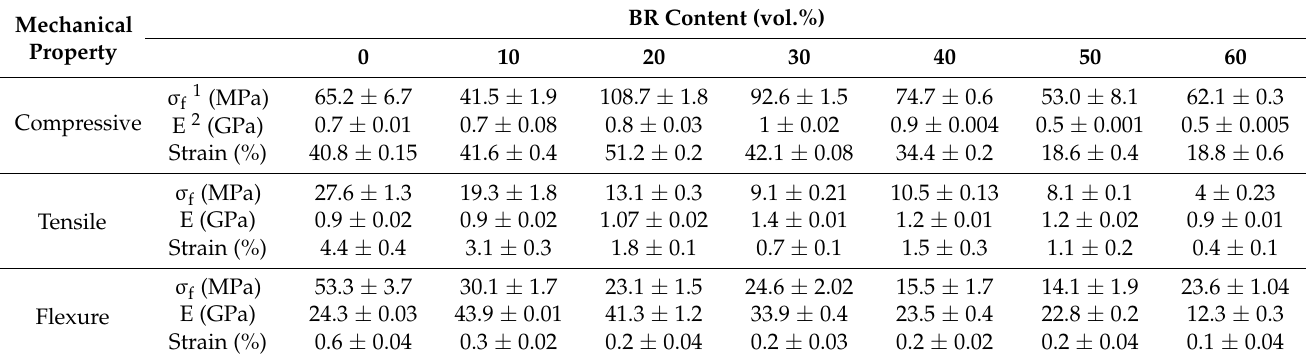
1 Failure strength. 2 Modulus of